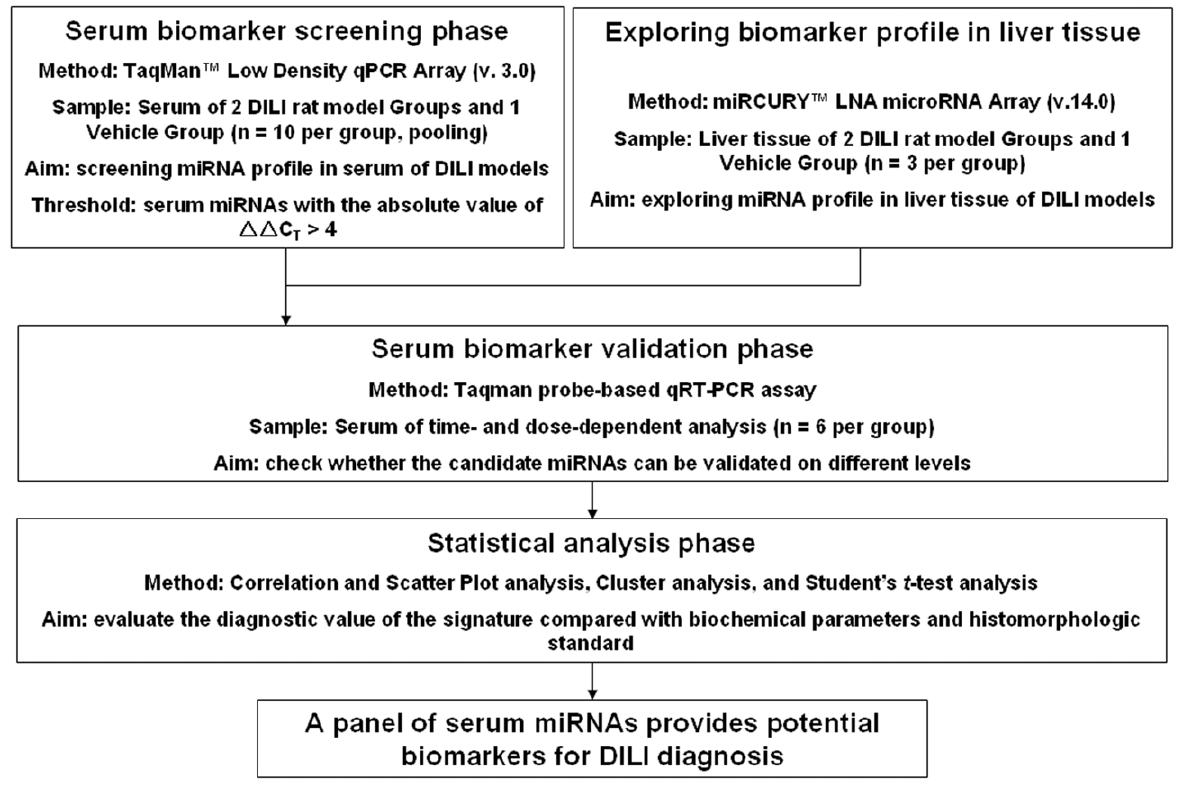
Figure 1. Overview of the experimental strategy.